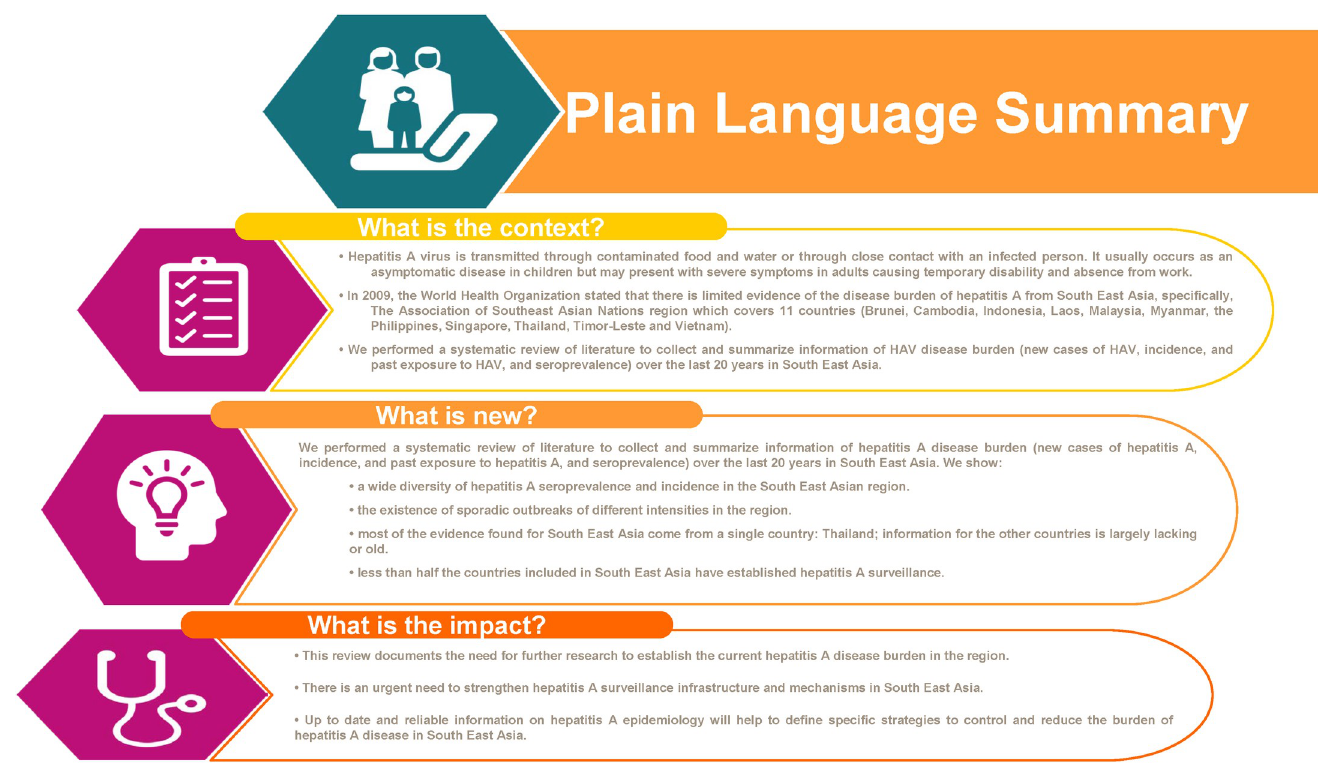
Fig 5. Plain language